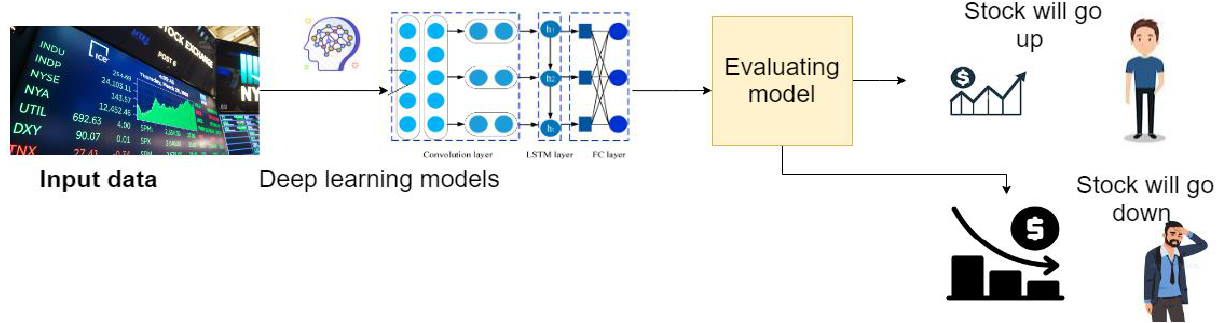
Figure 1. The framework of the deep learning model used to forecast the prices of stock markets.